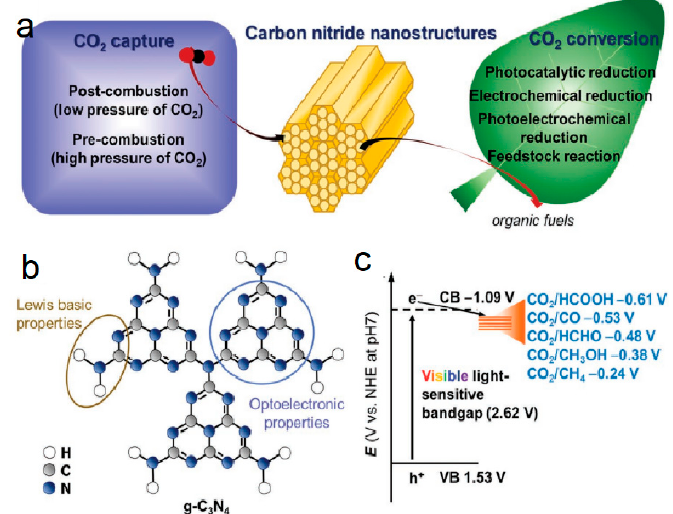
Figure 10. Schematic illustration of CO 2 capture and conversion to organic fuels using carbon nitride nanostructures ( a ), molecular structure ( b ) and band structure ( c ) of g-C 3 N 4 . Reproduced with permission [145], Copyright 2019, with permission from John Wiley and Sons.